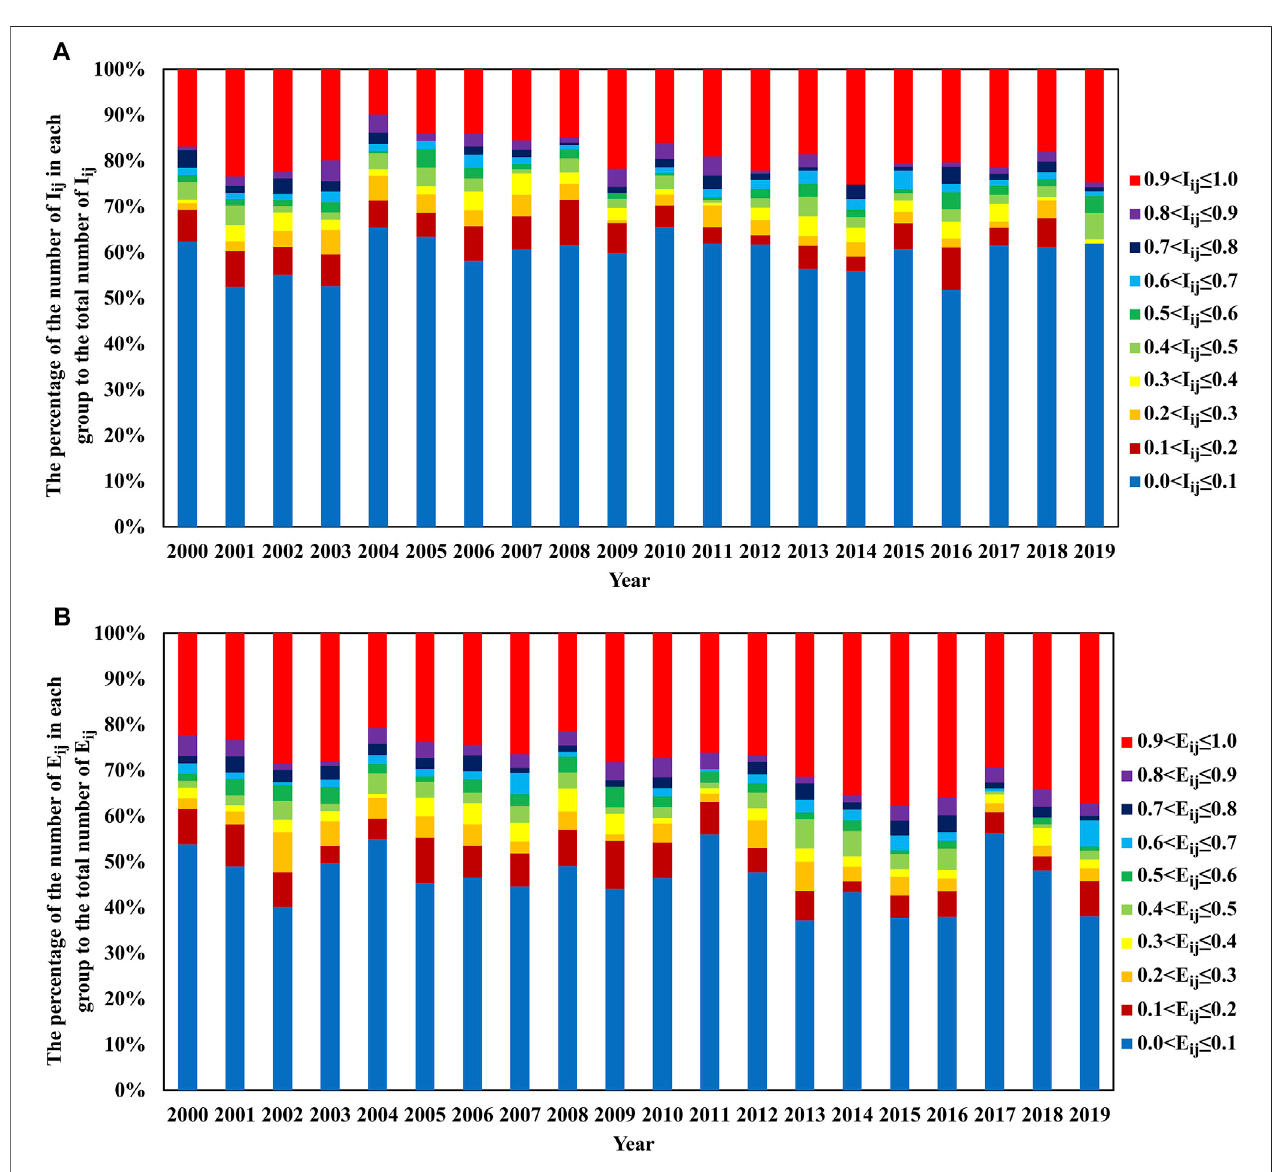
FIGURE3| Thepercentage ofthe number oftrade relationsin each group tothetotal number oftrade relations in CIDN and CEDN from 2000to 2019( (A) re fl ects the percentage related to import dependence in CIDN, and (B) re fl ects the percentage related to export dependence in CEDN).